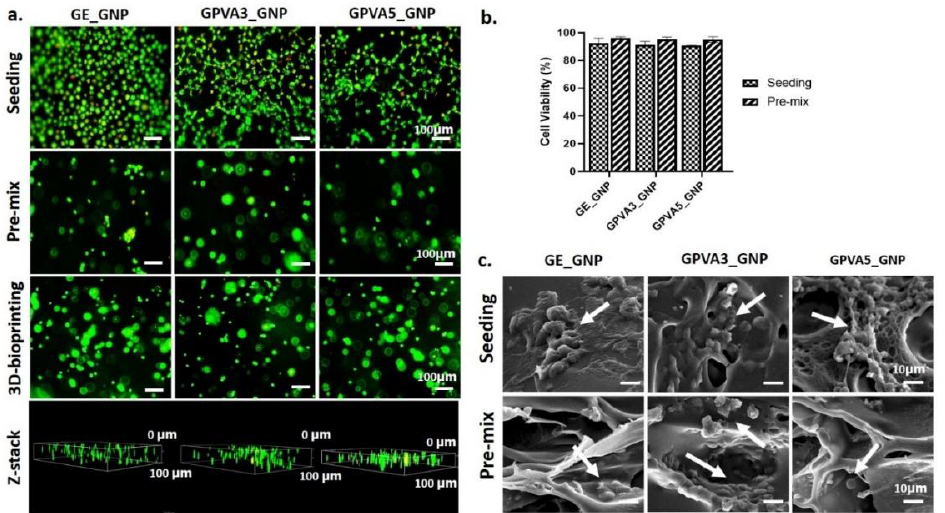
Figure 7. HDF cytotoxicity and interaction with hydrogels. ( a , b ) Live and dead assay and cytotoxicity evaluation of HDFs with hydrogel through seeding, pre-mix, and 3D-bioprinting techniques under 100× magnification. ( c ) Cell morphology on the surface of hydrogels, and after pre-mixing in the hydrogels, under 10× magnification.